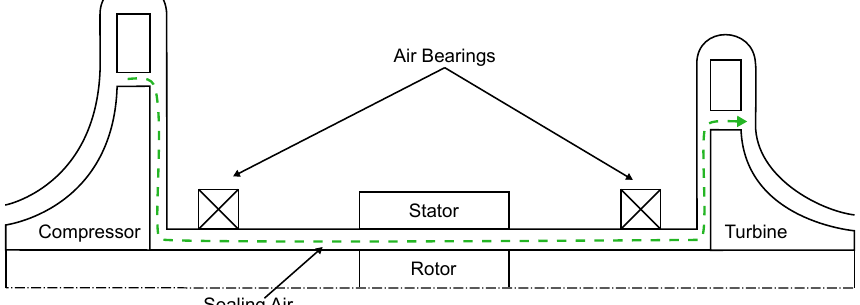
Figure 13. Sealing air path in a fuel cell